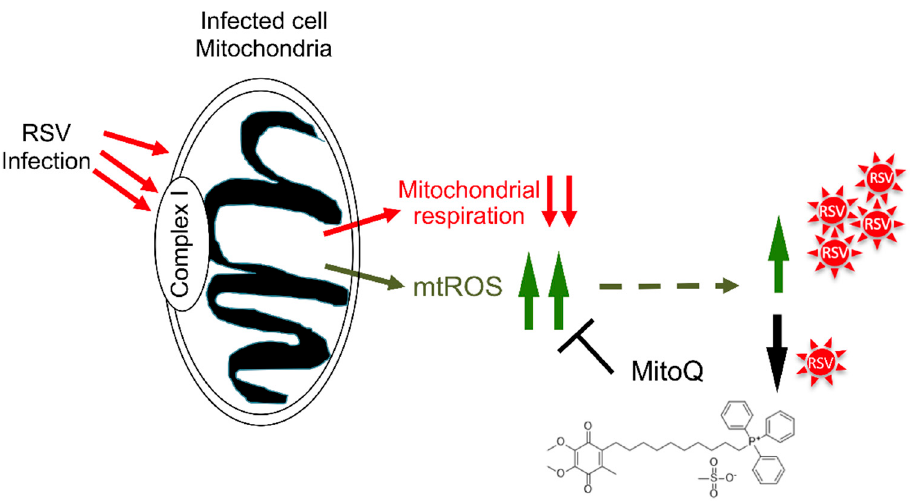
Figure 7. Schematic representation of the impact of RSV on host cell mitochondria. RSV infection leads to multiple impacts on the host cell mitochondria [19], in part through targeting complex I, including inhibition of host mitochondrial respiratory activity and enhanced mtROS generation to promote RSV infectious virus production. Blocking mtROS production using the mitochondrially-targeted antioxidant MitoQ limits RSV infection.